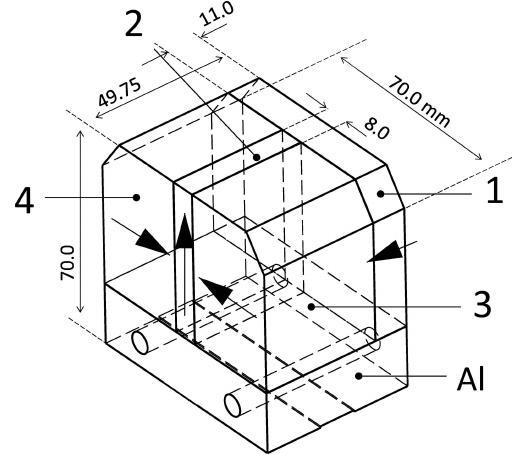
Figure 3 Detail of the production drawings of the north half-pole with the standard indexing and dimensions in millimetres. At the bottom is the aluminium (Al) support on top of which the four magnets are glued.